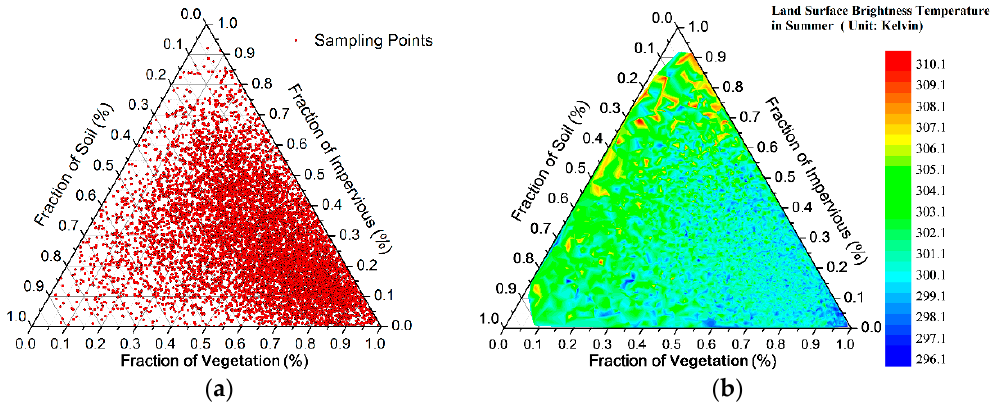
Figure 9. TTC for three-endmember fractions overlaid on all the brightness temperature values of the sample points. The transition from blue to red suggests an increase in brightness temperature. ( a ) The fraction of each sampling point; ( b ) overlay of all the brightness temperature data.